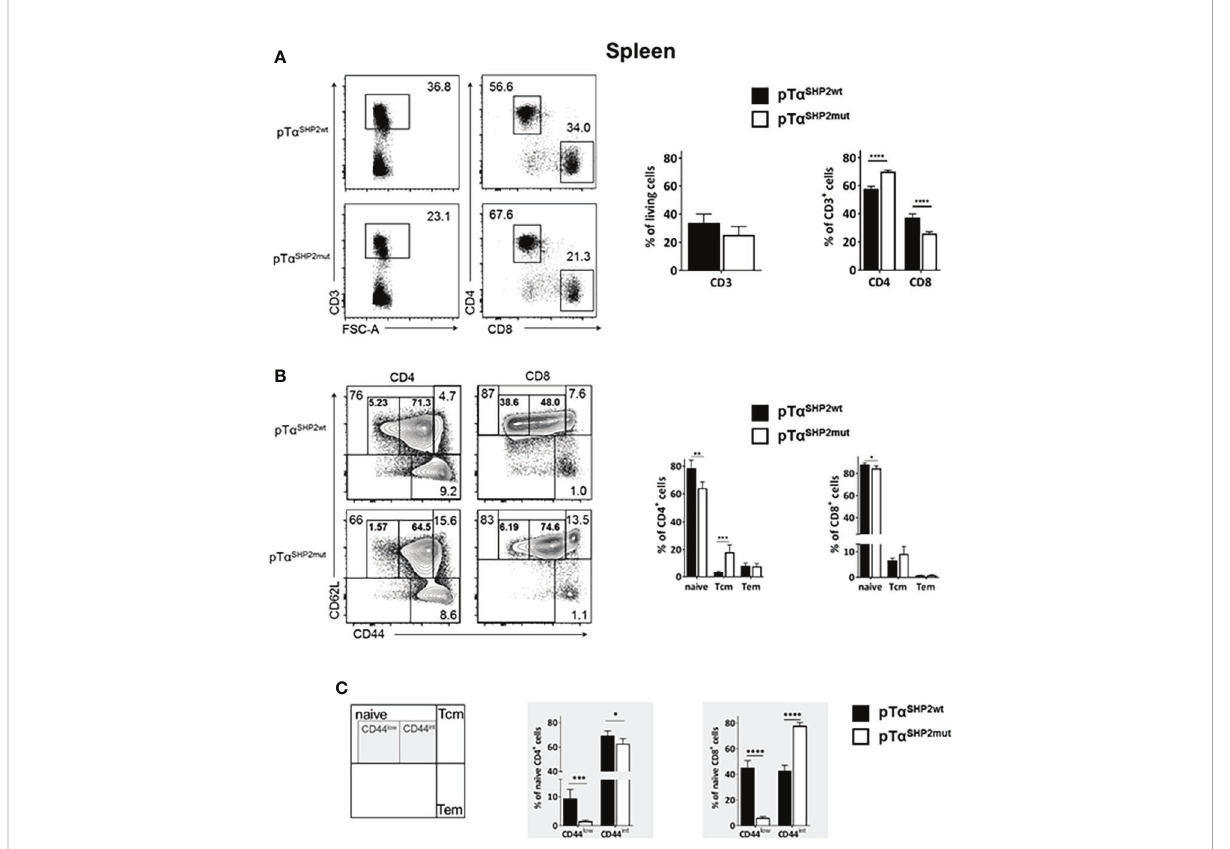
FIGURE 3 Alterations in T cell composition within the spleen of SHP2-D61Y mutant mice. Cells isolated from spleen of naïve pT a SHP2mut and pT a SHP2wt control mice were gated on single living cells and used for further FACS analysis. (A) FACS plots and graphs show frequencies of CD3 + T cells within the spleen and a shift in the CD4:CD8 T cell ratio. (B) FACS plots and graphs show proportion of naïve, central memory (Tcm) and effector memory T cells (Tem) in both CD4 + and CD8 + T cell subsets. (C) Frequencies of CD44 low and CD44 intermediate (CD44 int ) naïve T cells in the spleen, marked by grey squares. Data is representative for 2 independent experiments with n=5 mice each. (*p<0.05, **p<0.01, ***p<0.001, ****p<0.0001, Student ’ s t-test, mean +